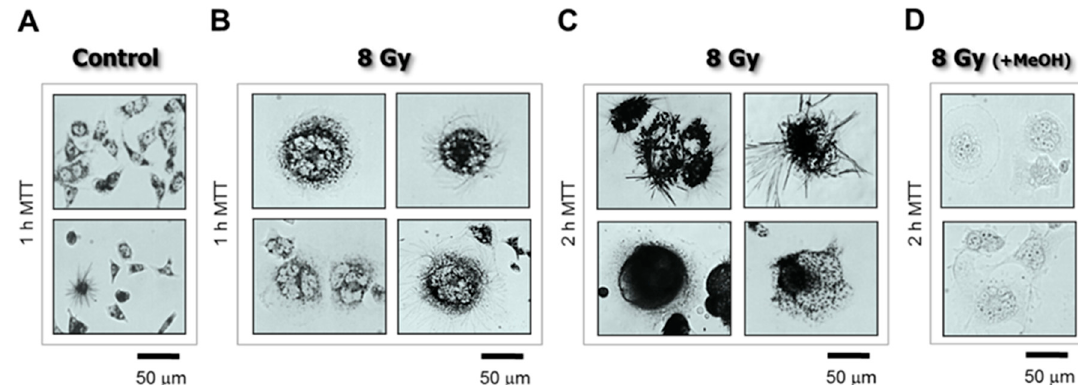
Figure 3. Bright-field microscopy images depicting the metabolic activity of HCT116p53 − / − cultures before ( A ) and 3 days after 8-Gy irradiation ( B – D ). Metabolic activity was measured by the ability of the cells to convert the yellow 3-(4,5-dimethylthiazol-2-yl)-2,5-diphenyl-tetrazolium bromide (MTT) to its purple formazan metabolite, appearing as dark granules and crystals. Cells were incubated with MTT (0.5 mg/mL) for 1 h ( A , B ) or 2 h ( C , D ). As a negative control, cells in some dishes were first treated with methanol to inhibit their metabolic activity, and then incubated with MTT ( D ). Data obtained from Mirzayans et al. [3].